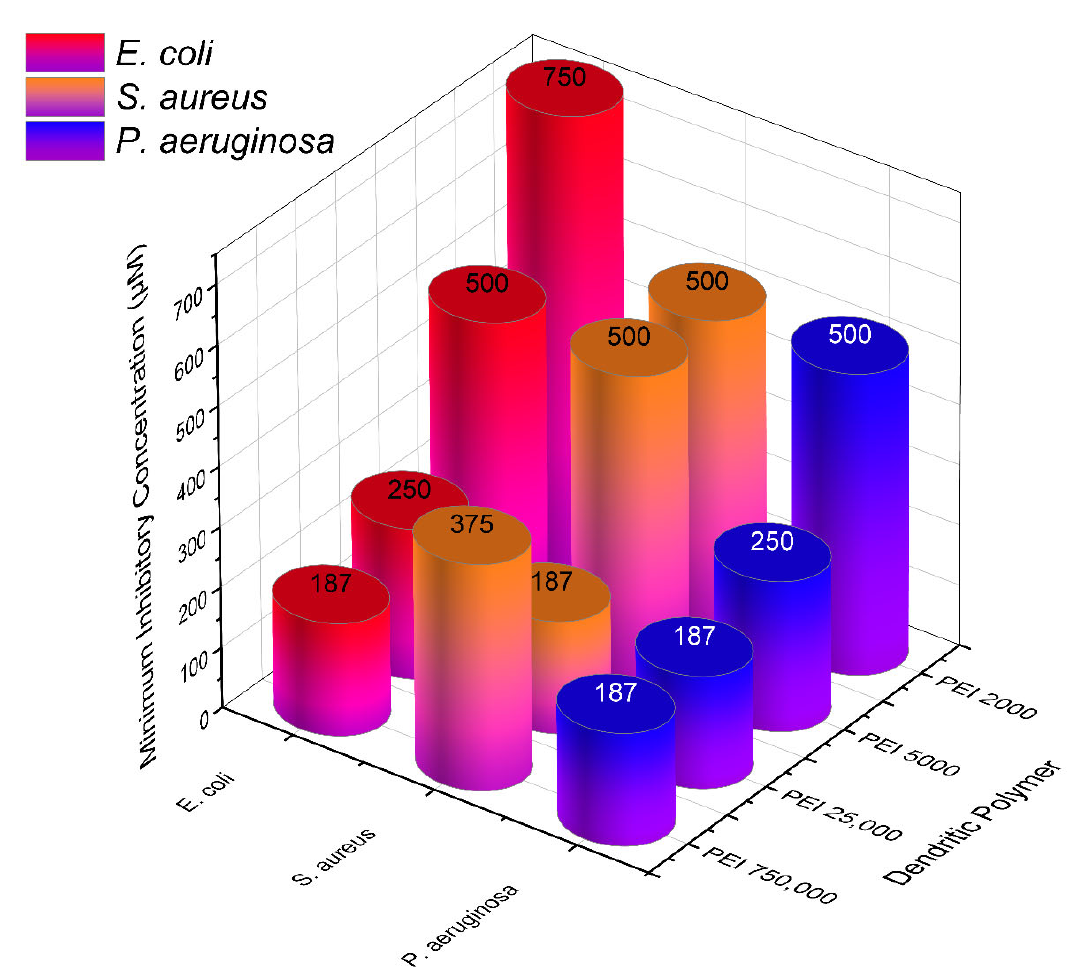
Figure 6. Minimum inhibitory concentrations (MIC) for all PEI Ag Nps solutions tested for the model Gram ‐ negative microorganisms, Escherichia coli ATCC 25922 and Pseudomonas aeruginosa ATCC 27853, and Gram ‐ positive Staphylococcus aureus ATCC 29213.